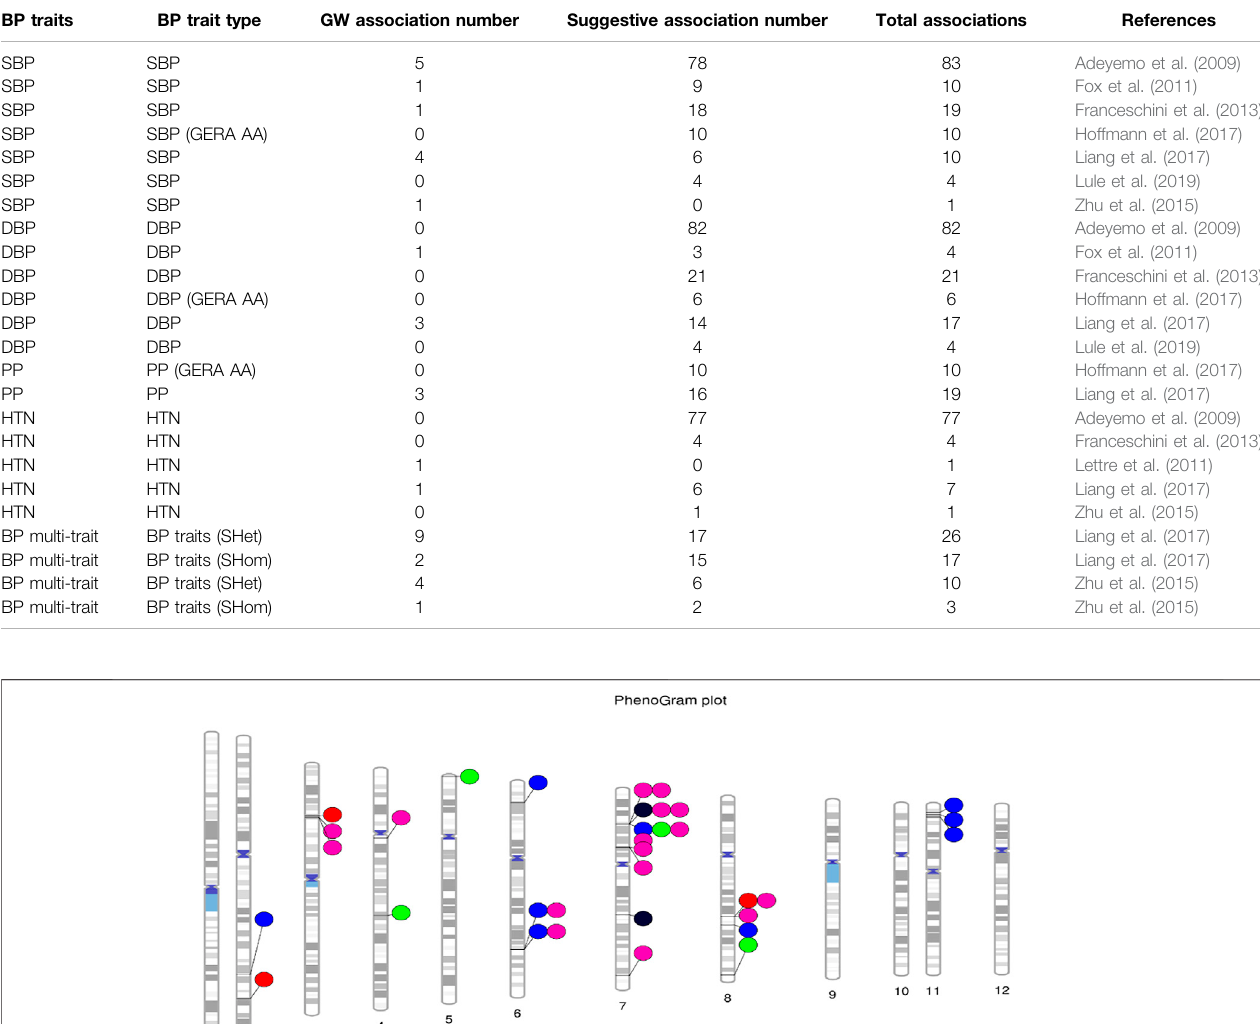
TABLE 4 | GWAS associated SNPs detected for BP-related traits in the 10 studies, with 100% African-ancestry participants.